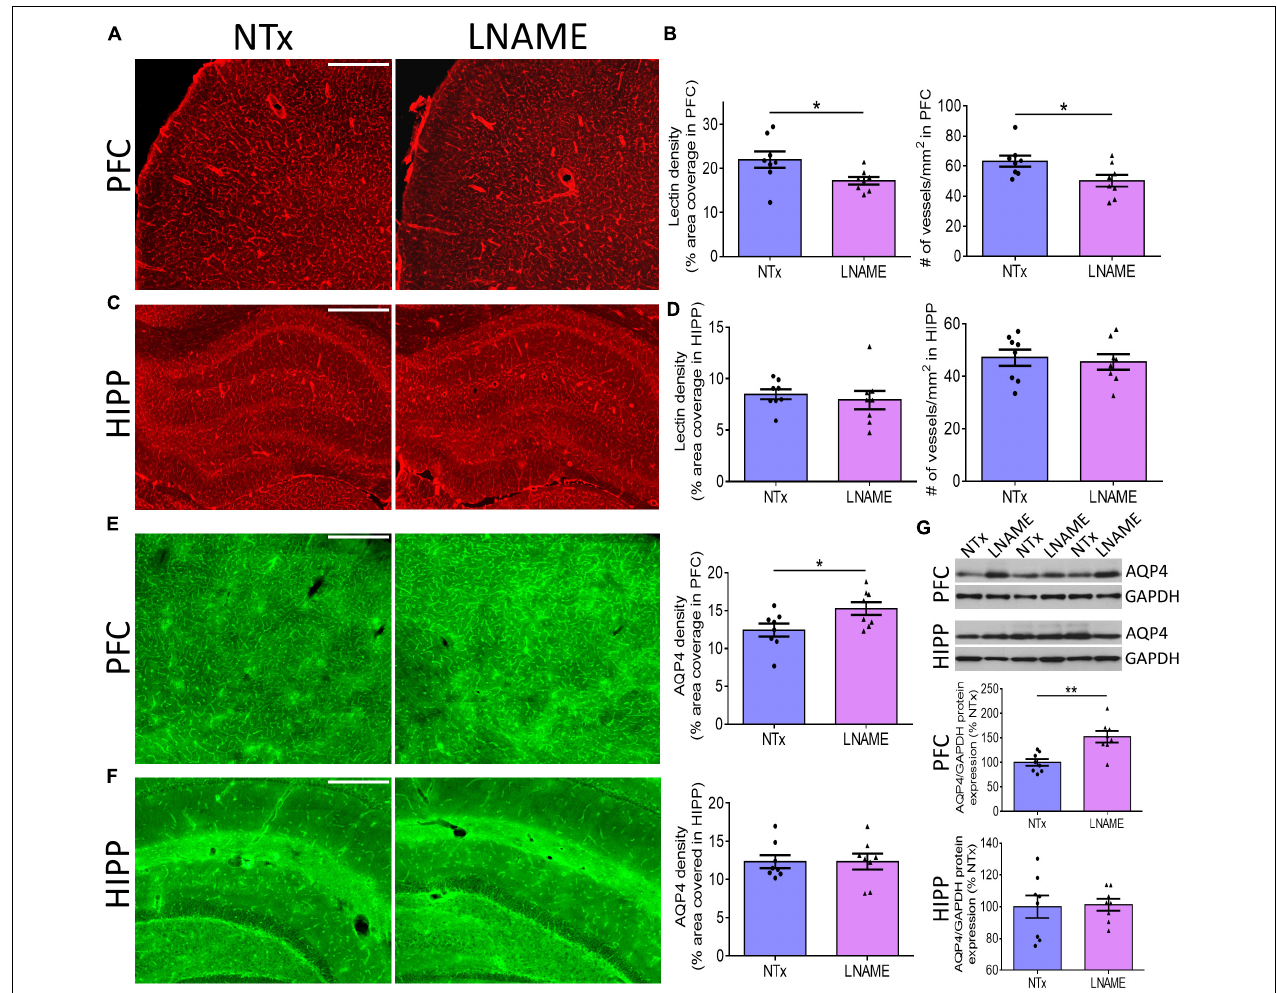
FIGURE 3 | Transient hypertension results in irreversible compromise to the cerebrovasculature despite extended recovery. (A) Representative images of lectin fluorescence coverage in PFC; scale bar = 500 µ m. (B) Quantification of lectin area coverage (left) and number of vessels (right) in PFC: Both lectin coverage ( p = 0.036) and number of lectin-positive vessels ( p = 0.032) are significantly lower in L-NAME group. (C) Representative images of lectin fluorescence coverage in HIPP; scale bar = 750 µ m. (D) Quantification of lectin coverage (left) and number of vessels (right) in HIPP: Both lectin coverage ( p = 0.593) and number of vessels (0.700) are not significantly different between groups ( p = 0.593). (E) Representative images (left and middle) and quantification (right) of AQP4 fluorescence coverage in PFC: AQP4 immunoreactivity coverage is higher in L-NAME group ( p = 0.036); scale bar = 500 µ m. (F) Representative images (left and middle) and quantification (right) of AQP4 fluorescence coverage in HIPP: AQP4 immunoreactivity coverage is unchanged ( p = 0.999). (G) Representative immunoblots (top) and immunoblot quantification of AQP4 protein expression normalized to GAPDH in PFC (middle) and HIPP (bottom); L-NAME increased AQP4 protein expression in PFC ( p = 0.002) but not in HIPP ( p = 0.879). Scale bar = 500 µ m. Significance was calculated by t -test. * and ** denote p < 0.05 and p < 0.01 respectively; n = 8 rats per